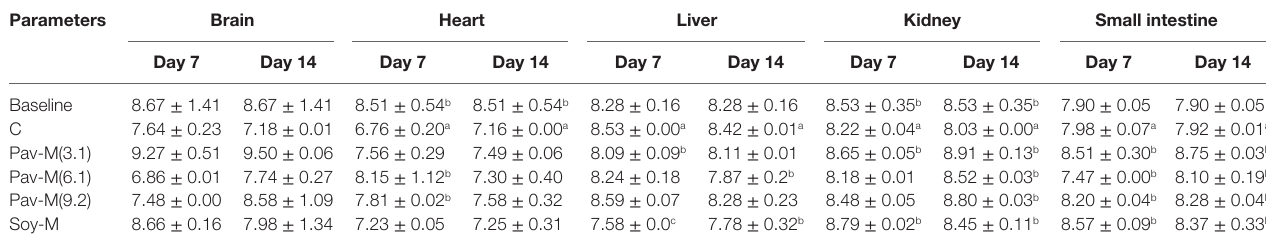
Value = mean ± SD (n = 3). Data within each column with different superscript alphabets are statistically different (P < 0.05). C, control; Pav-M(3.1), group with daily administration of 3.1 µl/g animal wt. pro-milk extract from A. pavonina seed; Pav-M(6.1), group with daily administration of 6.1 µl/g animal wt. pro-milk extract from A. pavonina seed; Pav-M(9.2), group with daily administration of 9.2 µl/g animal wt. pro-milk extract from A. pavonina seed; Soy-M, group with